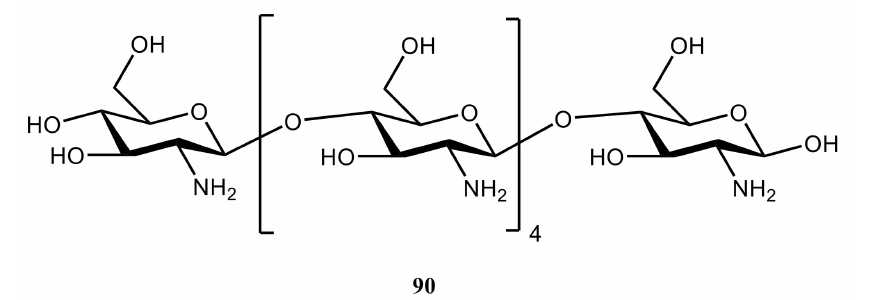
Figure 44. Chemical structure of hexameric chitozan.